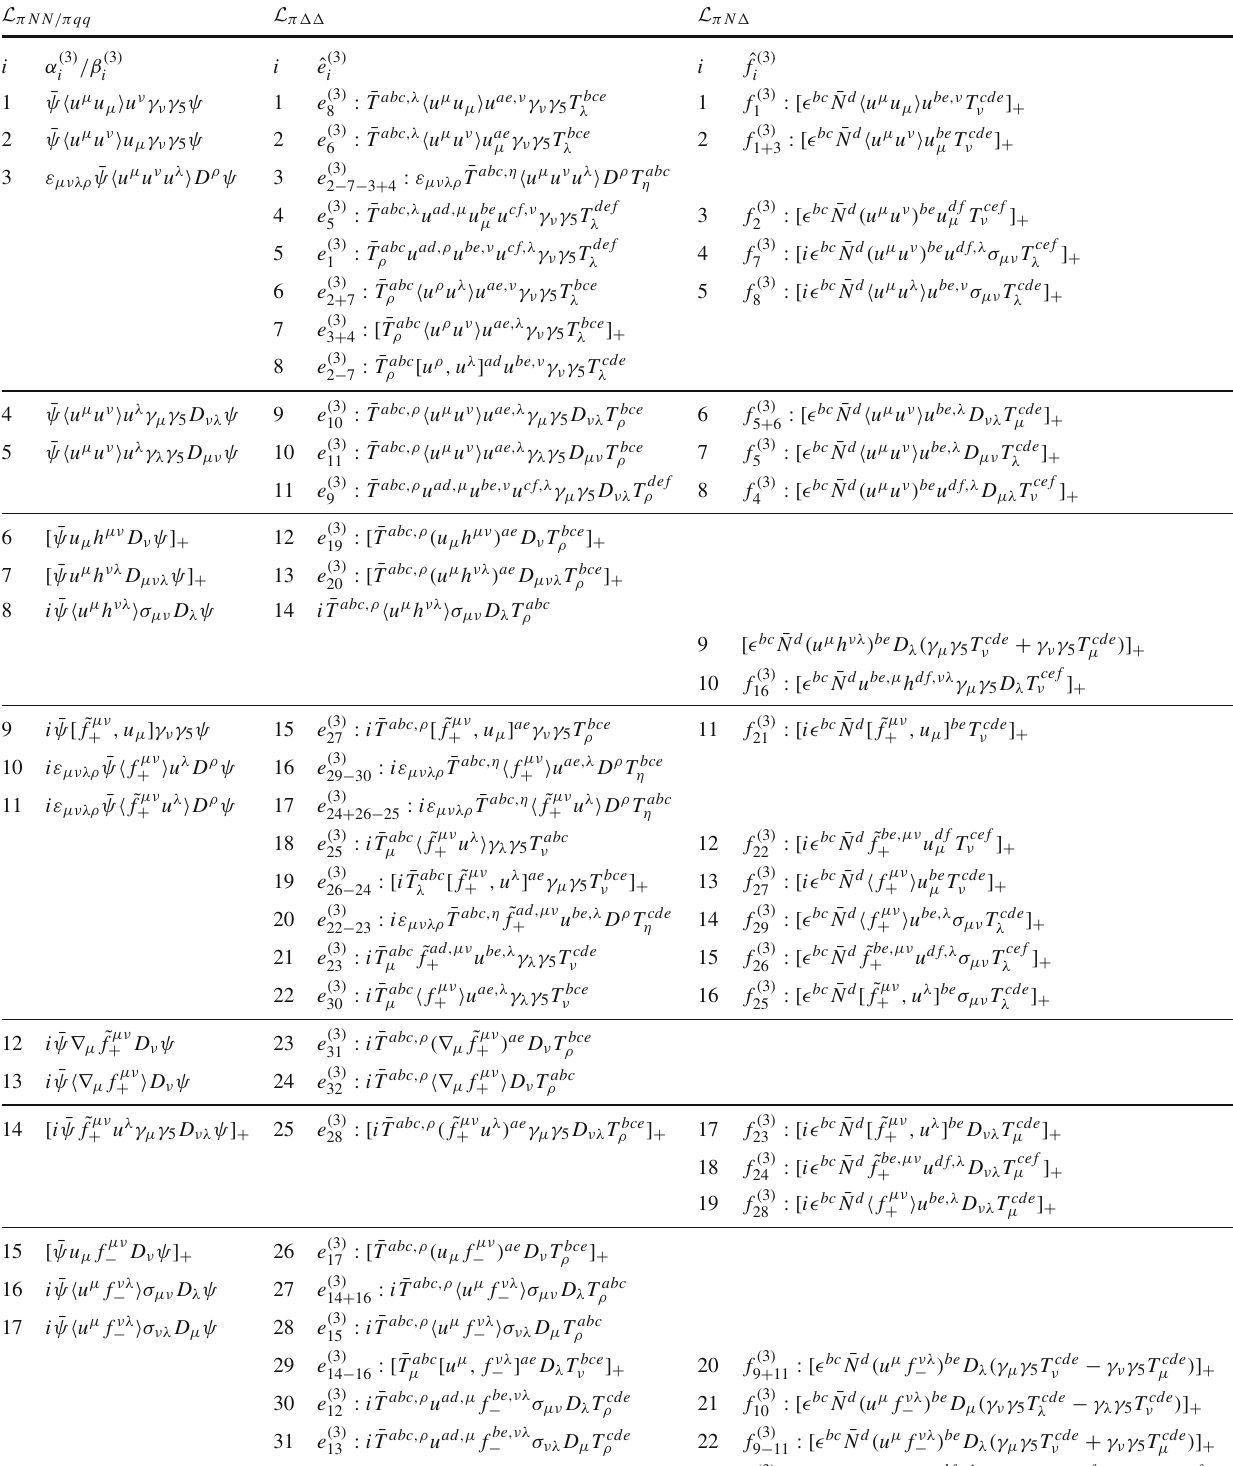
use i to label the interaction terms and α denote their coupling constants, respectively. The meaning of symbols ( 3 ) like e is explained in the 2 − 7 − 3 + 4